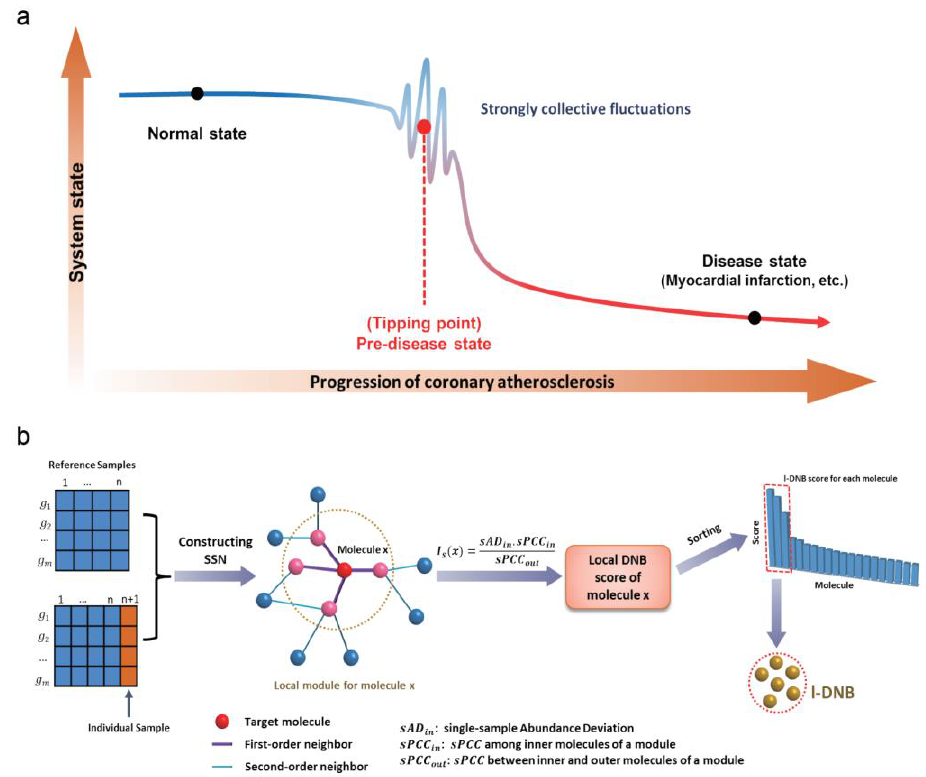
Figure 2. ( a ) The schematic diagram for the dynamical progression of human coronary atherosclerosis. The process of disease development can be divided into three states — normal state, predisease state and disease state. The system is stable and ordered at a normal state. With evolution of the disease, the system reaches the predisease state (i.e., tipping point), which has no substantial changes in pathological phenotype compared with the normal state, and it is reversible between the predisease state and normal state. However, when the system crosses the tipping point, it deteriorates rapidly, eventually leading to the major cardiovascular events. ( b ) The flowchart of the landscape dynamic network biomarkers (l-DNB) method to identify DNB molecules from a single